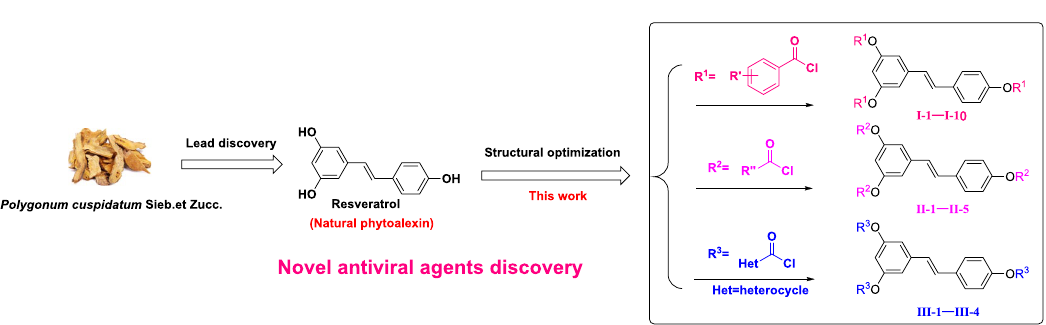
Figure 2. The design and synthesis of compounds I-1–I-10, II-1–II-5 and III-1–III-4